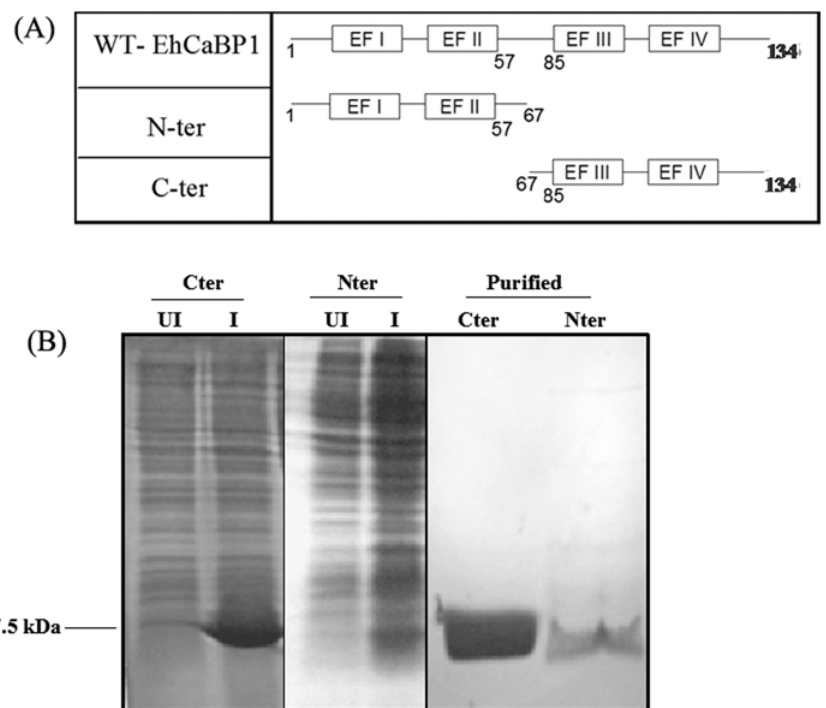
Figure 1. Cloning and Expression of EhCaBP1 domains. (A) Schematic representation of EhCaBP1 domains. Nter protein lacks the carboxy terminus of the protein and contained only the initial 66 amino acids, while Cter protein lacks the initial 66 amino acids. (B) The induction and purification profiles for both the Nter and Cter domains are shown. Induced lysates from the bacterial cells expressing the EhCaBP1 domains are resolved on a 15% SDS-PAGE and the gel is stained with Coomassie Brilliant Blue R-250.